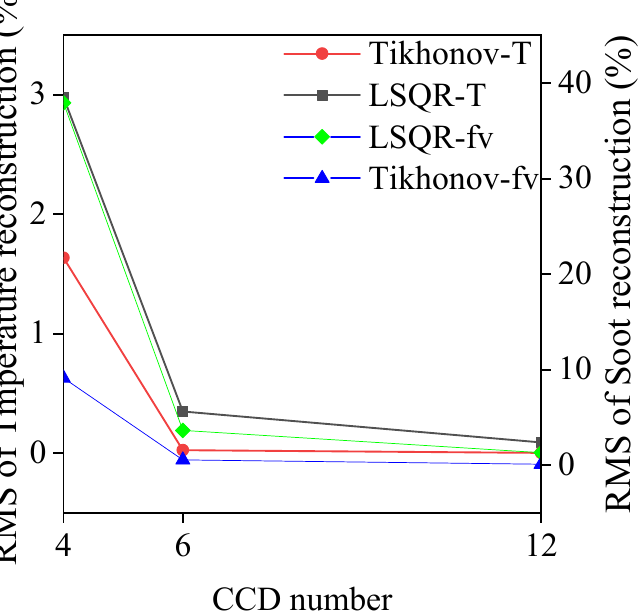
Figure 8. The RMSEs of the two algorithms for the reconstruction temperature and soot-concentration variation with the number of cameras.